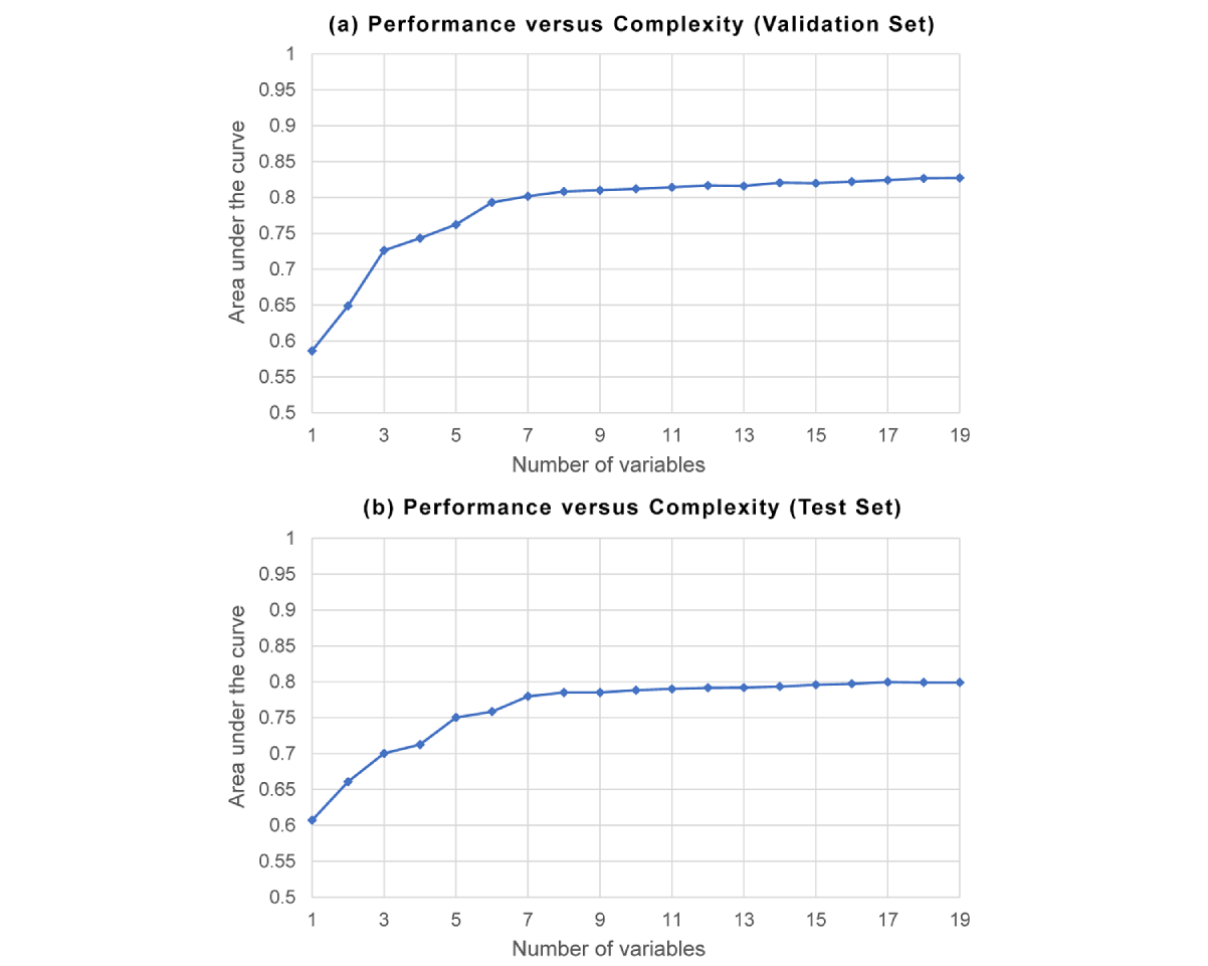
Figure 3. Model performance versus complexity for the implementation of the AutoScore on (a) the validation set and (b) the test set. The area under the curve reflects the discrimination performance, whereas the number of variables represents the complexity of the